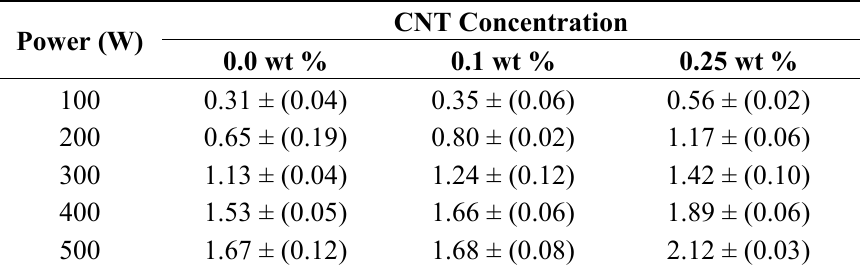
Figure 5. Tung oil-based resin bearing 0.25 wt % of CNTs and cured under microwaves at 100 W for 10 min, followed by 200 W for 10 min, and a 1 h 30 min post-cure step at 140 °C in a convection oven analyzed by: ( A ) TEM; ( B ) SEM; and ( C ) optical microscopy at 10× magnification. Table 1. Heating rates of carbon nanotubes (CNTs) in tung oil. Values are presented in °C s − 1